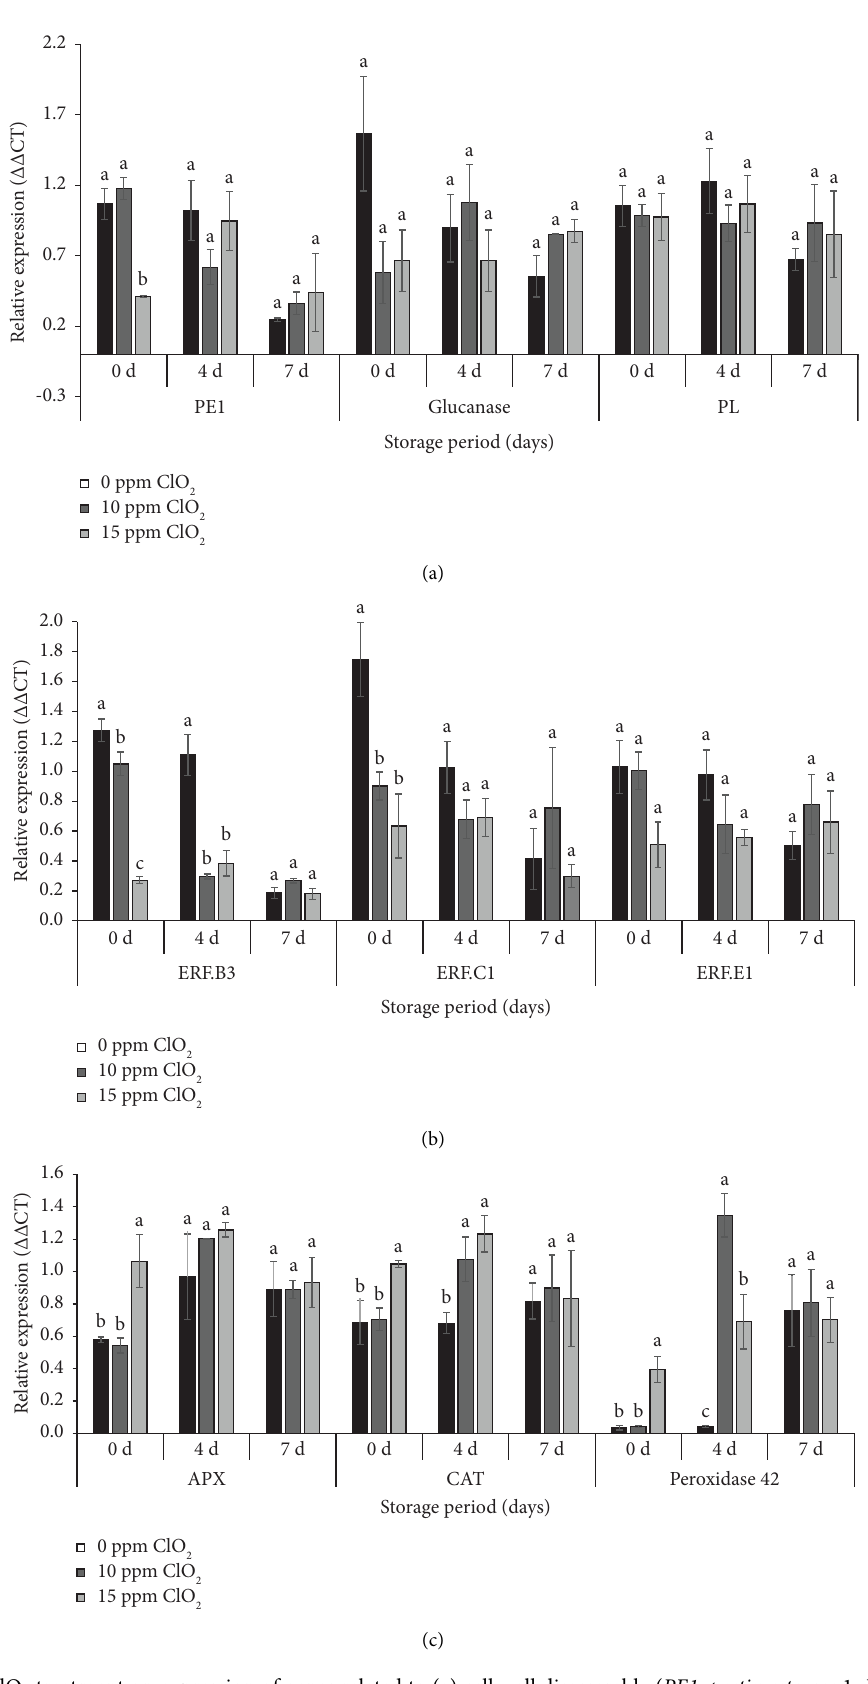
Figure 4: Efect of ClO 2 treatment on expression of genes related to (a) cell wall disassembly ( PE1 : pectin esterase 1; PL : pectate lyase ), (b) ripening-associated ethylene response factors (ERF.B3/C1/E1) , and (c) antioxidant defense ( APX : ascorbate peroxidase ; CAT : catalase; peroxidase 42 ) in fruits stored at 13 ° C for 12 days. Te bar represents the mean ± standard error of three biological replicates. Diferent lowercase letters in the graph indicate statistically signifcant diferences at P < 0 . 05. ClO 2 -induced antioxidant activity in